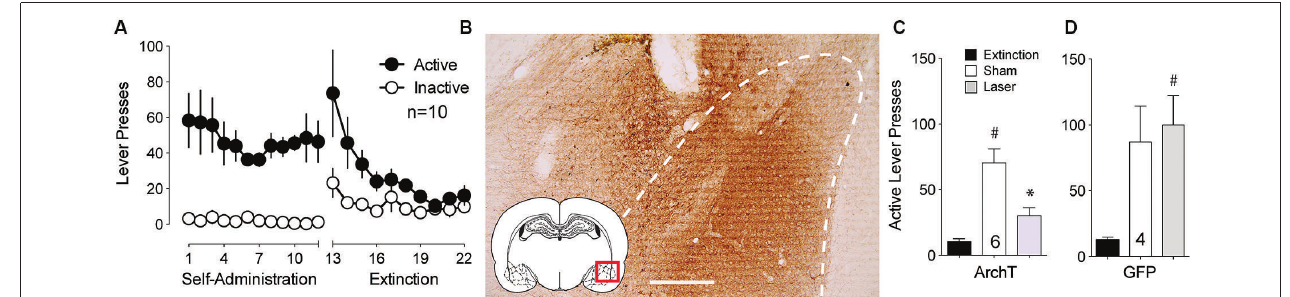
cocaine seeking. # p < 0.05 compared with extinction levels of lever pressing for ArchT-expressing animals using a paired Student’s t -test with probability values adjusted for multiple comparisons according to Bonferroni, Sham t (5) = 5.50, p < 0.01; Laser t (5) = 4.15, p < 0.01. * p < 0.05 comparing laser and sham treatments, t (5) = 3.99, p = 0.010. For GFP controls, Sham t (3) = 2.91, p = 0.06; Laser t (3) = 4.32, p = 0.02. Comparing laser and sham treatments, t (3) = 0.77, p =